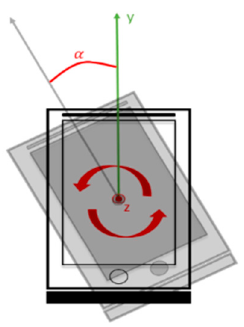
Figure 3. Three axes of the smartphone.